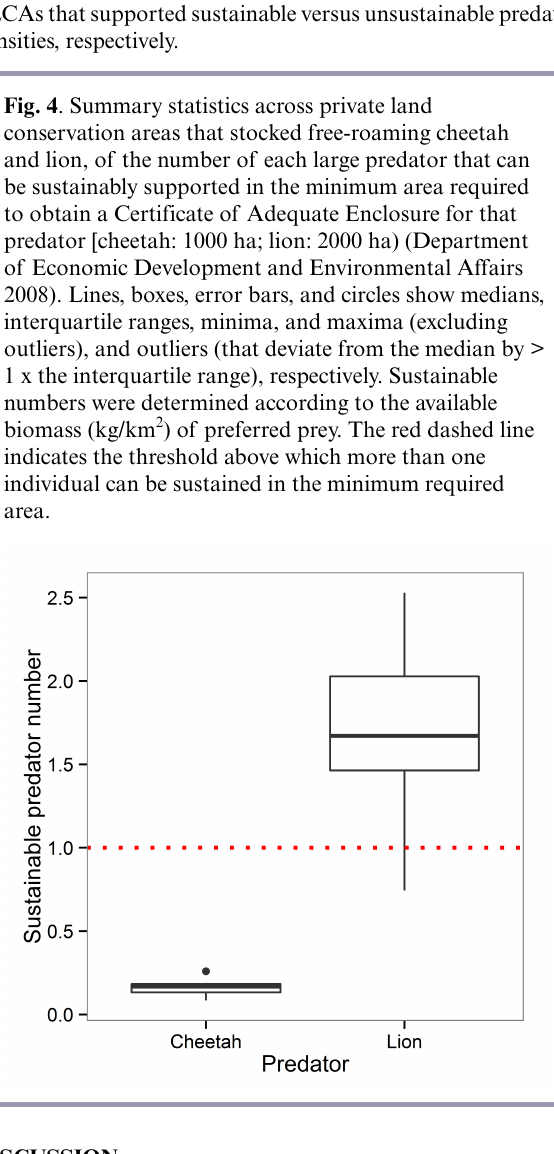
Fig. 4 . Summary statistics across private